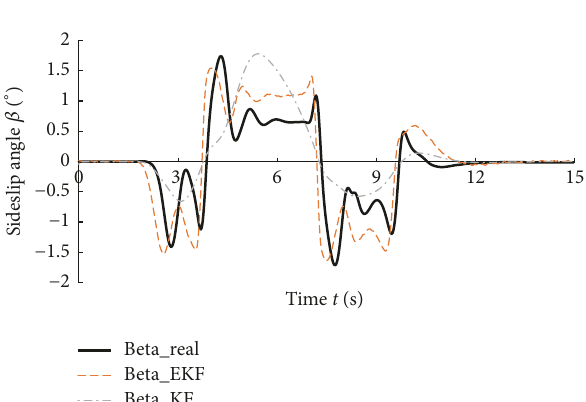
Figure 6: Vehicle state ( 𝜇 = 0.2 ).